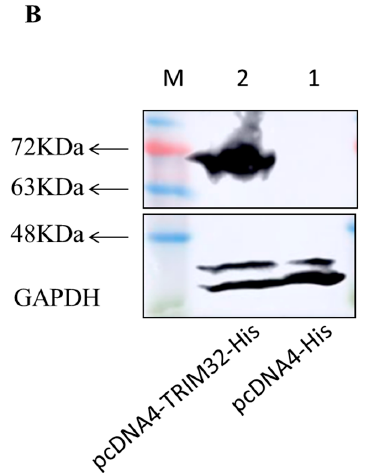
Figure 5. Immunofluorescence assay (IFA) and Western blotting assay to analyze the expression of TRIM32. ( A ) Immunofluorescence assay to detect the expression of recombinant plasmid pcDNA4-TRIM32-His in Epithelioma papulosum cyprinid (EPC) cell line, the empty vector was transfected as the control. Cell nucleus was stained by DAPI (4,6-diamidino-2-phenylindole); ( B ) Western blotting assay to detect the expression of recombinant plasmid pcDNA4–TRIM32–His in EPC cell line. Lane 1 was transfected with pcDNA4–His empty vector as control while Lane 2 was transfected with the recombinant plasmids pcDNA4–TRIM32–His, GAPDH (glyceraldehyde 3-phosphate dehydrogenase) was used as the internal control in this test.